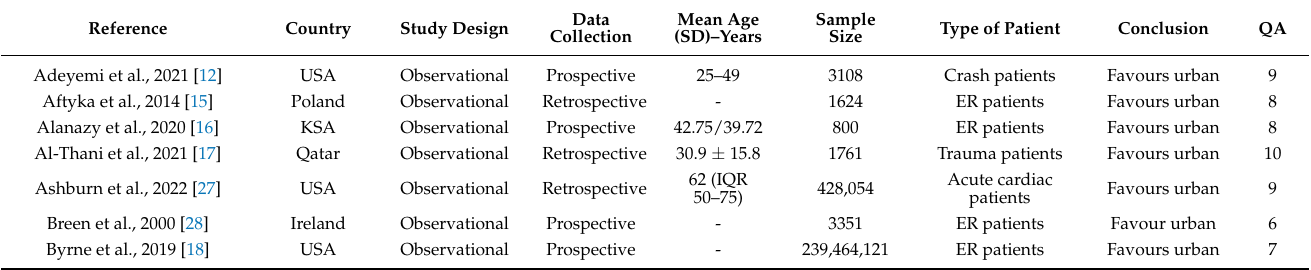
Table 1. Baseline characteristics and quality assessment results of the included studies in this